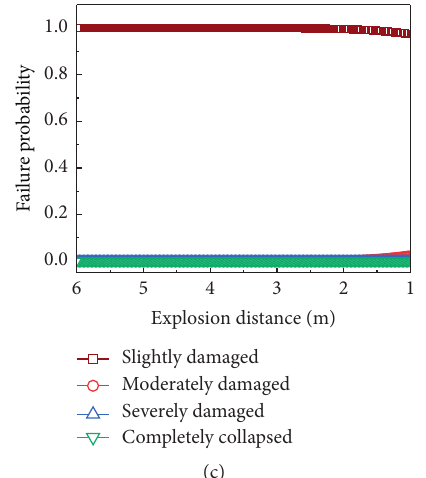
Figure 15: Failure probability curves of the pier under three types of car bombs: (a) 1# car bomb, (b) 2# car bomb, and (c) 3# car bomb.